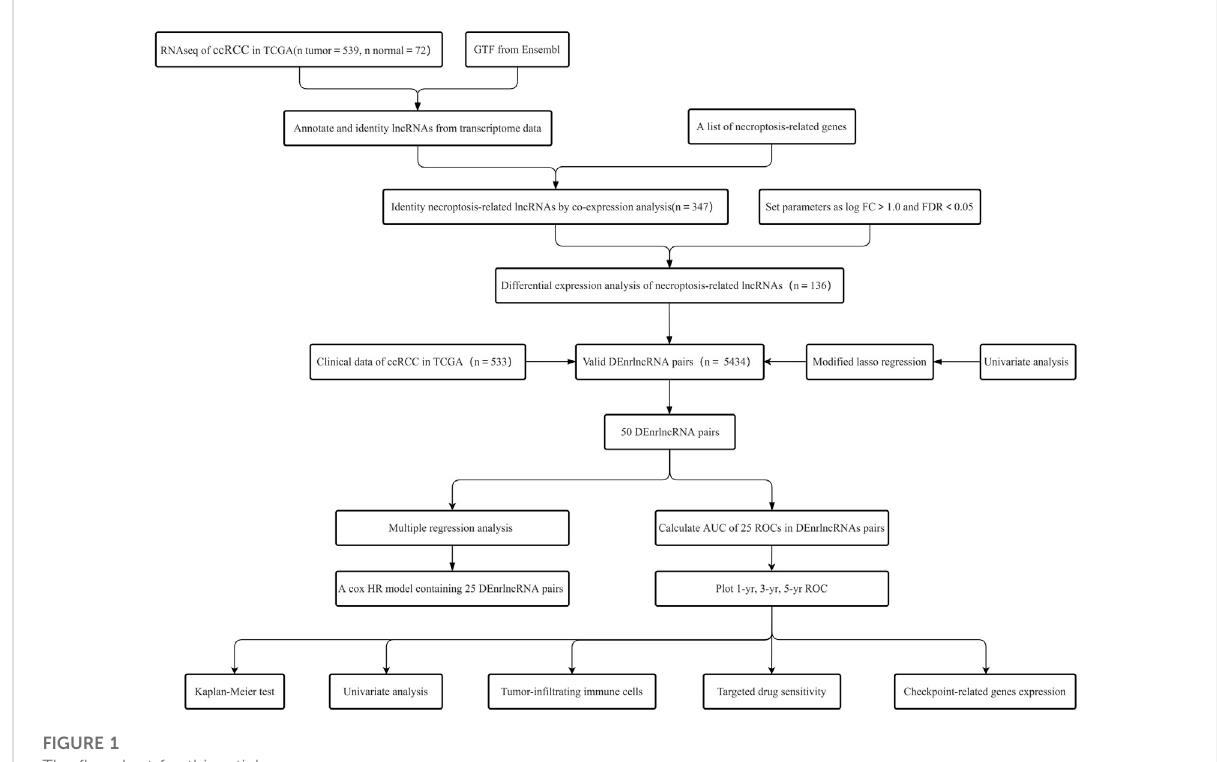
FIGURE 1 The fl owchart for this